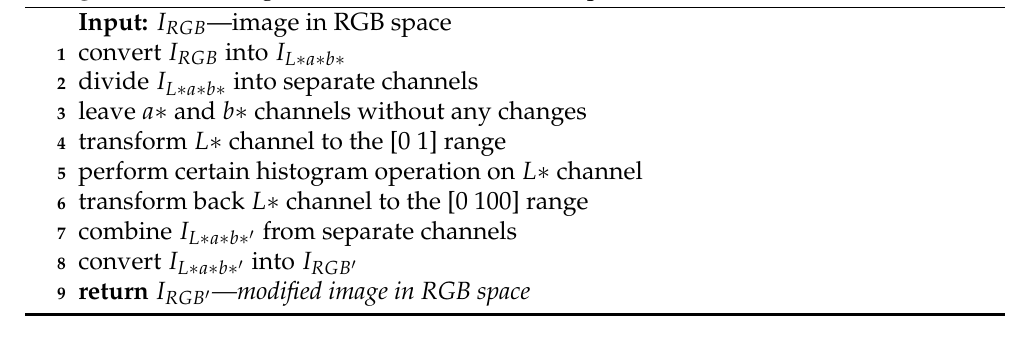
Algorithm 1: Histogram modification in L*a*b* space